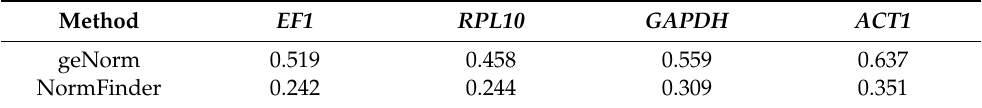
Table 1. Stability analysis of the candidate reference genes ribosomal protein L10 ( RPL10 ), glyceralde- hyde-3-phosphate dehydrogenase ( GAPDH ), elongation factor-1 alpha ( EF1 ), and beta actin 1 ( ACT1 ) ana- lyzed by geNorm (average expression stability or M value) and NormFinder (stability value) in different larval stages of Chrysodeixis includens .